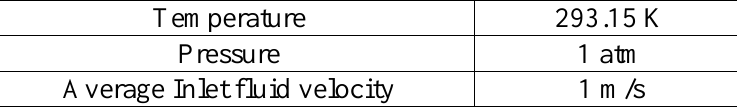
Table 1: Operation conditions of the electrostatic precipitator.